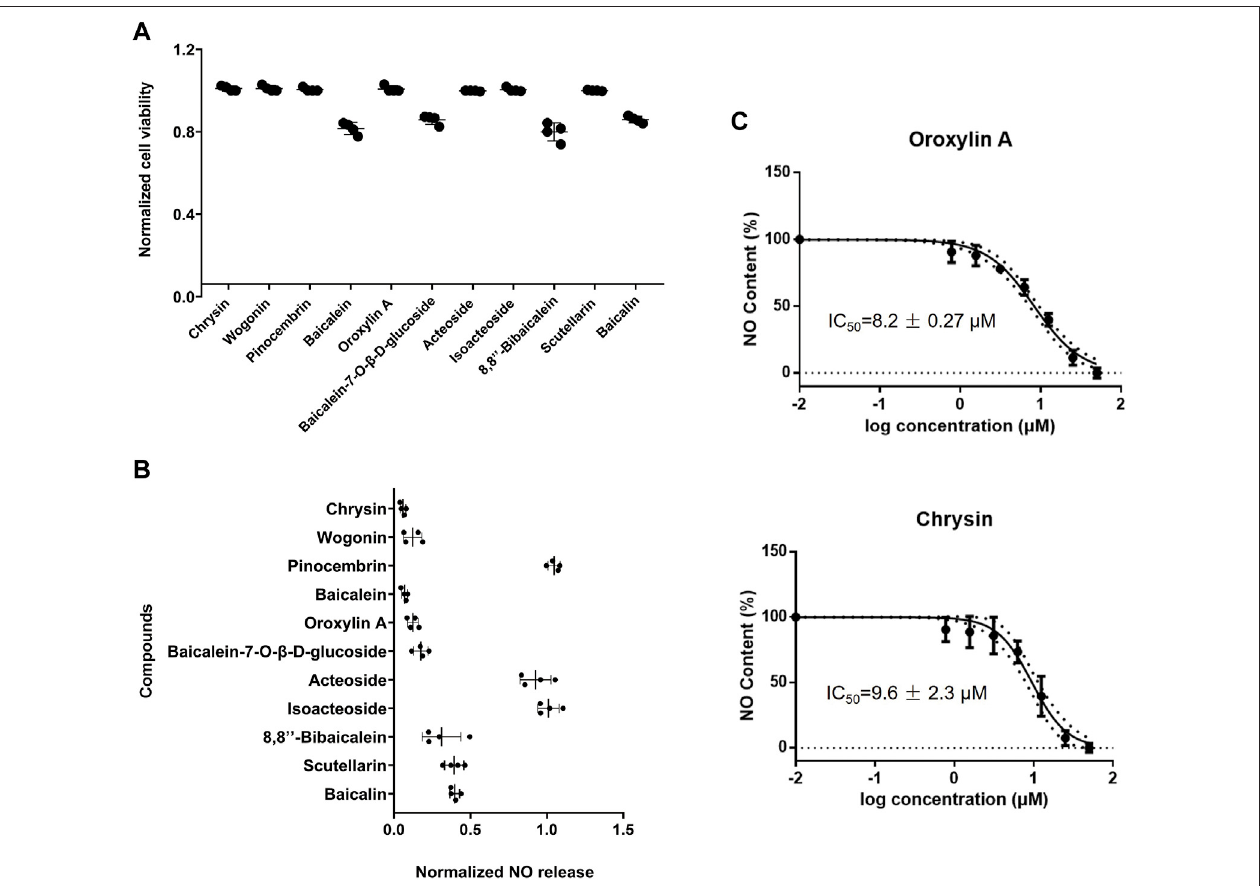
FIGURE 3 | Veri fi cation and screening of anti-in fl ammatory activity of active components in Raw264.7 cells. (A) Viability of Raw264.7 cells. Cells were treated with 50 μ M corresponding reagents and then measured by MTT assay, following by the normalization of cell viability. (B) Screening results in Raw264.7 cells. Cells were treatedwith1 µg/mlLPSand50 μ Mcorrespondingreagents,andthenmeasuredthereleaseofNO,followedbythenormalizationofinhibitionrate. (C) Dose-dependent inhibitory response of LPS-induced NO release in Raw264.7 cells. Cells were treated with 1 µg/ml LPS and serial concentration of chrysin and oroxylin A (0.78, 1.56, 3.12, 6.25, 12.5, 25,and 50 μ M) and then measuredthe release ofNO, followed bythe normalization of inhibition rate. All datawere reported asthe mean ofthree independent